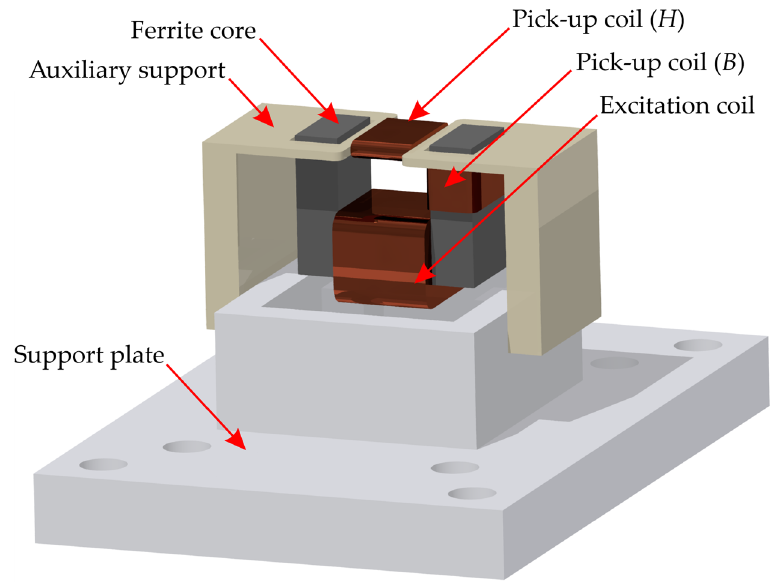
Figure 3. Transducer model.